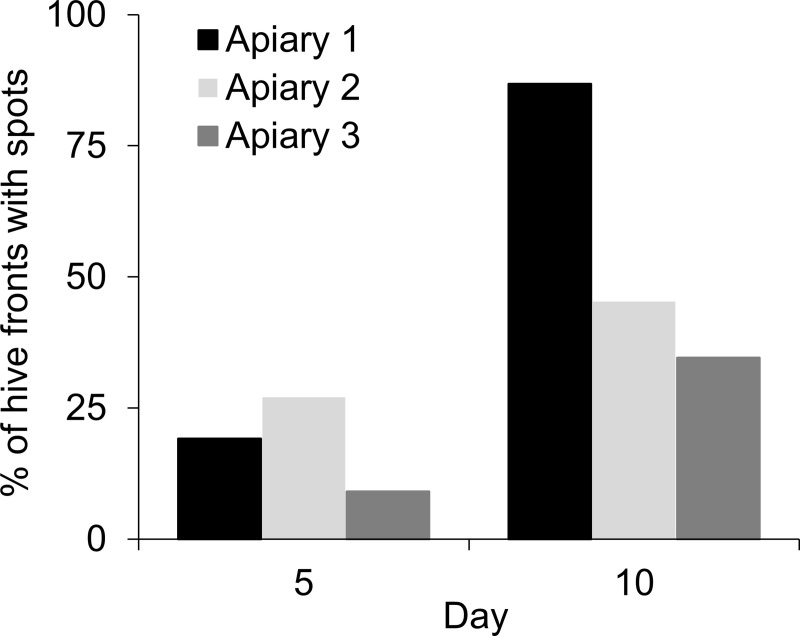
Spotting on hive fronts increased over time.The hive fronts of a total of 339 colonies in 3 apiaries were washed with water to remove spots and the presence or absence of spots on hive fronts was evaluated 5 and 10 days later.